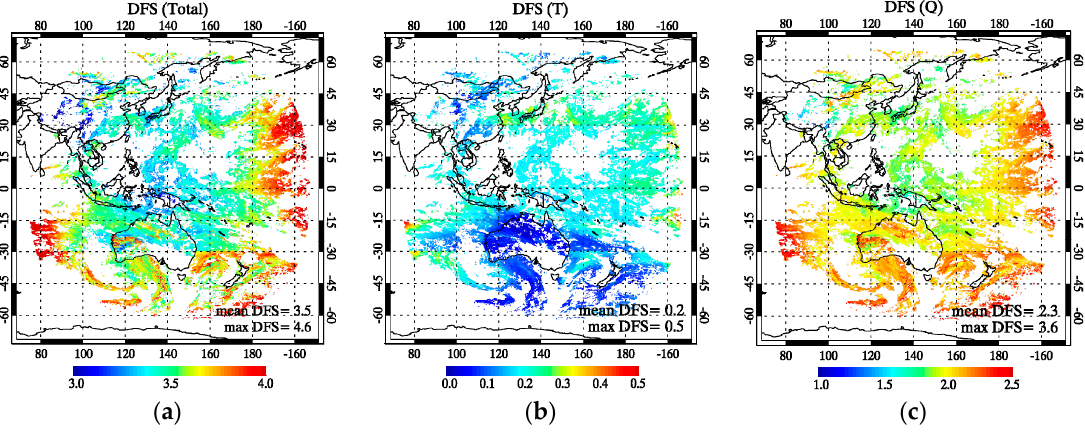
Figure 7. ( a ) Degrees of freedom for ( a ) total; ( b ) temperature; and ( c ) moisture signal on 1 August 2016, 00 UTC.